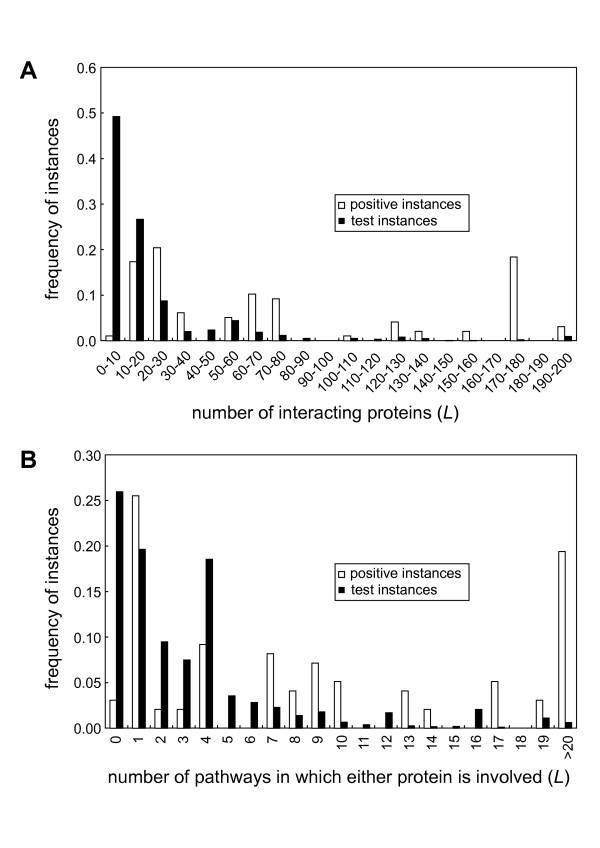
Frequency distributions of (A) the number of interacting proteins (L) (attribute no. 46) and (B) the number of pathways in which either protein is involved (L) (attribute no. 48). For both attributes, the difference between the frequency distributions of the positive and test instances is statistically significant (P < 10-15) by the two-sample Kolmogorov-Smirnov test.